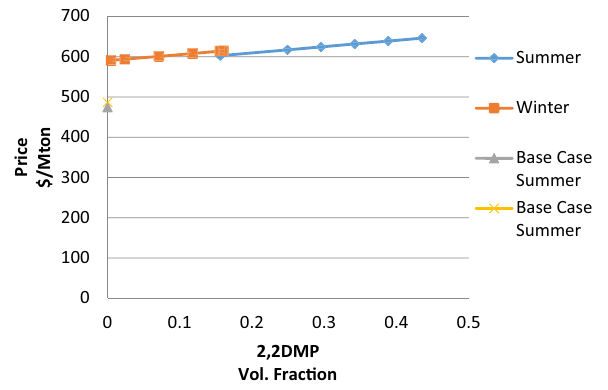
Fig. 37 Effect of adding 2,2DMP and 20 vol% DME on LPG price